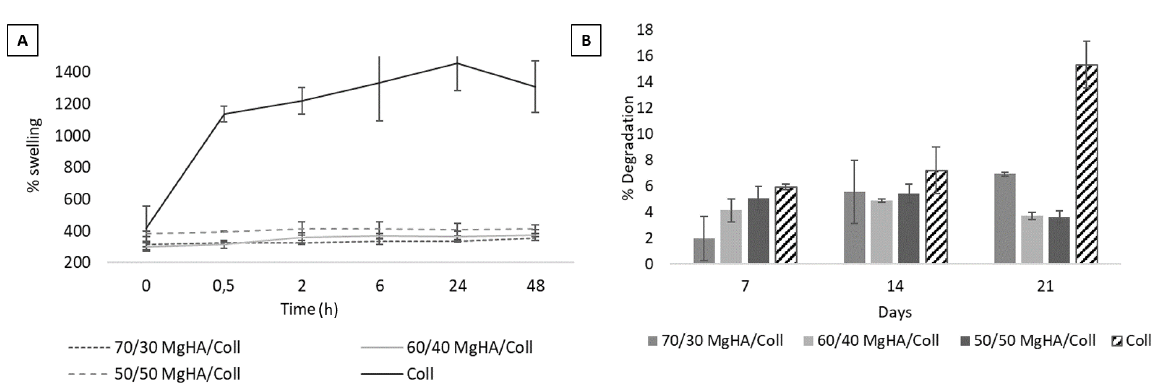
Figure 3. ( A ) Evaluation of swelling behavior, in PBS and 37 °C, for all the scaffolds compositions (MgHA/Coll 70/30, 60/40, 50/50 and Coll). ( B ) Evaluation of percentage of scaffold degradation in PBS and 37 °C.